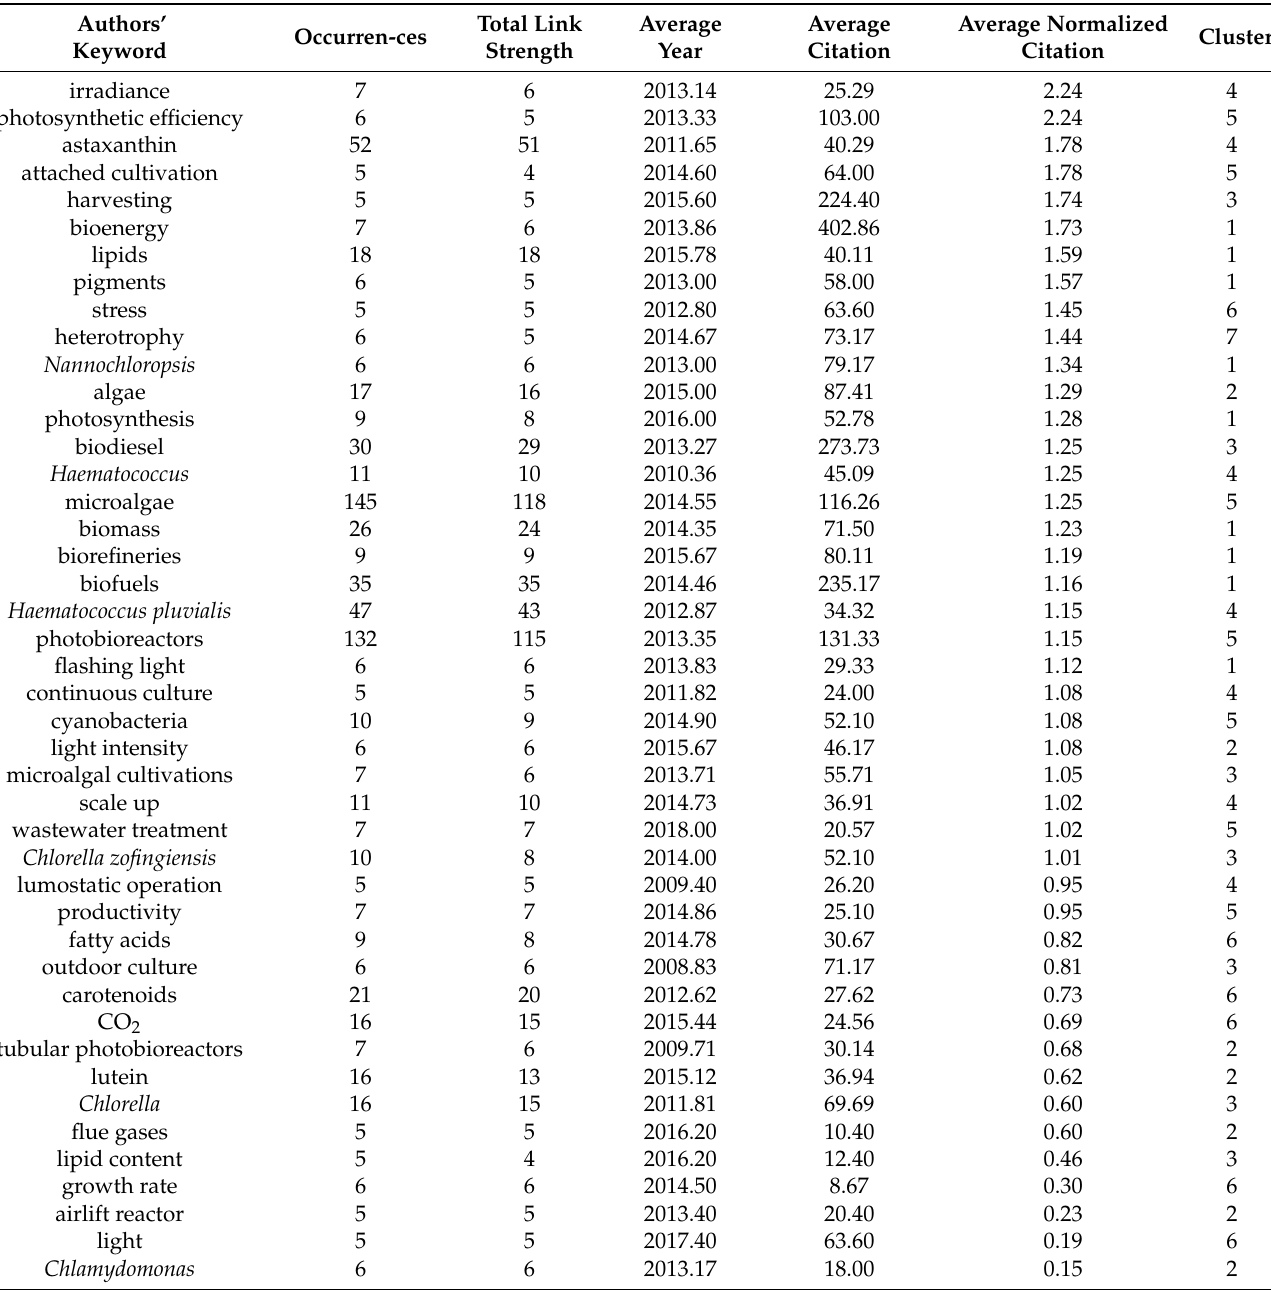
Table 4. Qualitative summary of the influence of authors’